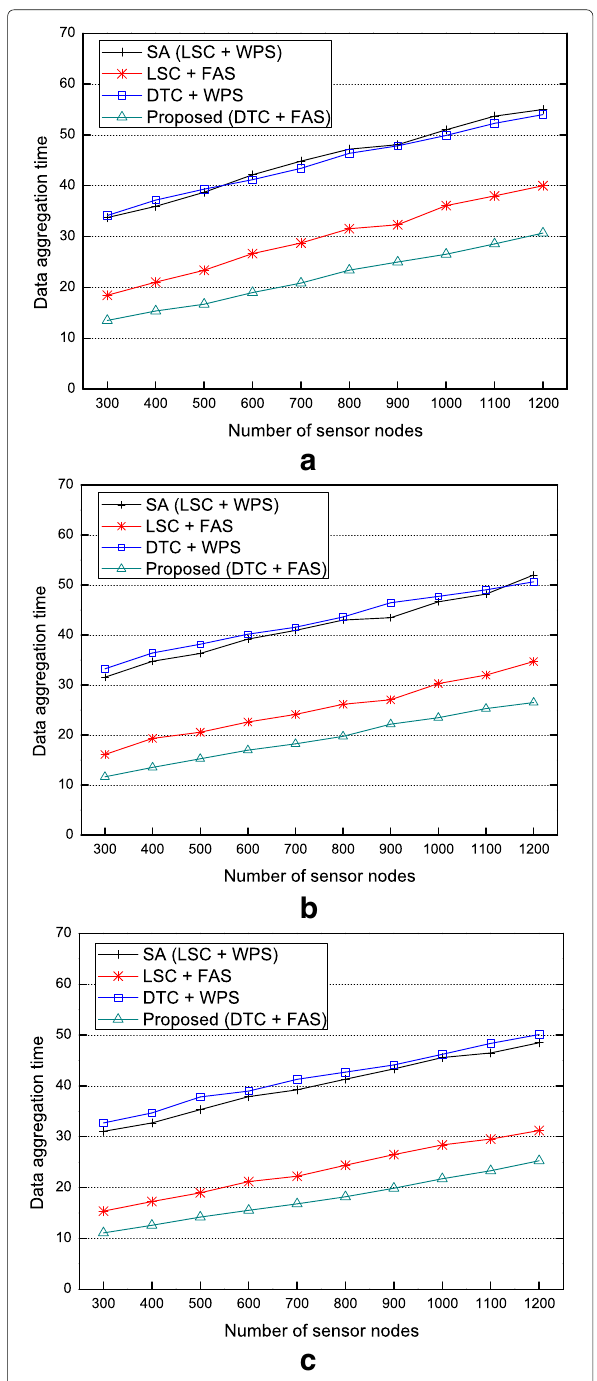
Fig. 5 Data aggregation time with different number of nodes. a τ = 5 . b τ = 10 . c τ = 20 (5% duty